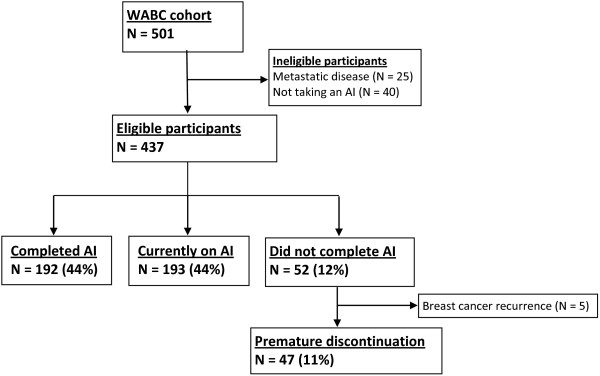
Patient selection and follow up.